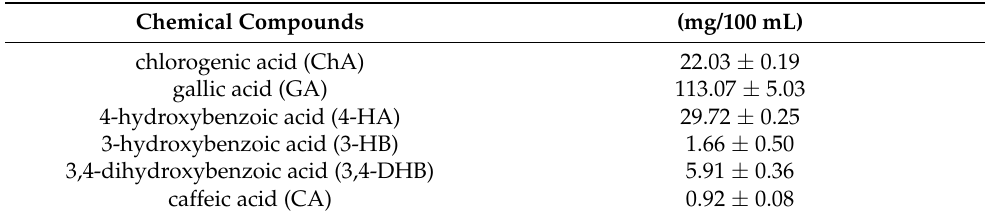
Table 1. Concentrations of phenolic acids of the ethanolic extracts from E. angustifolium (FEE). Values are the mean of three replicate determinations ( n = 3).